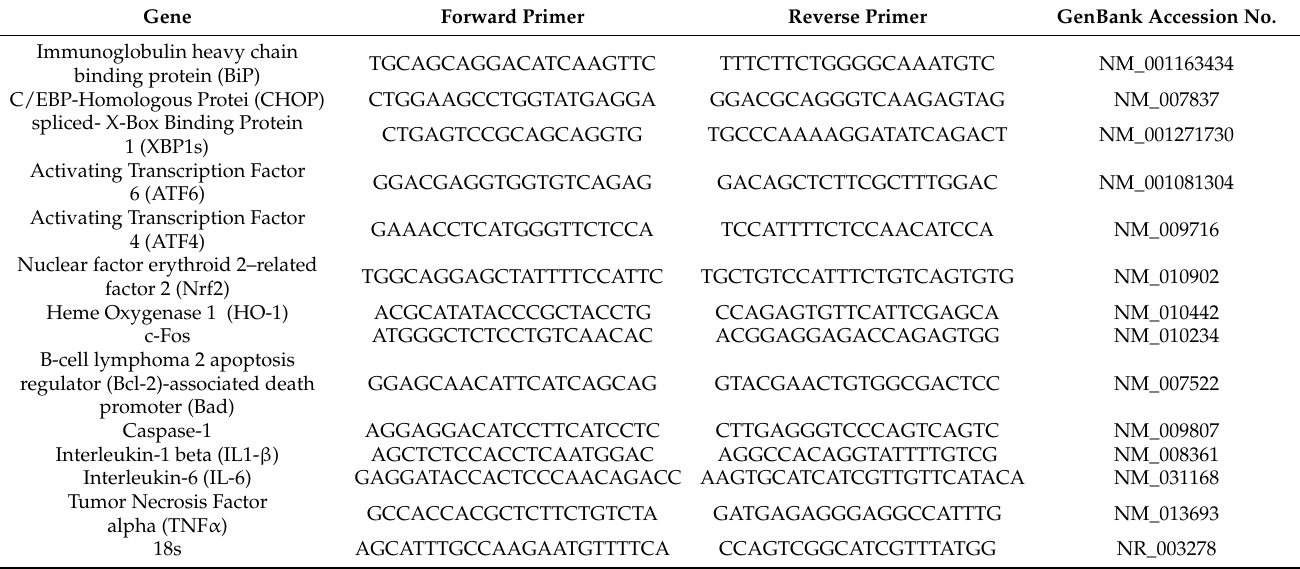
Table 1. Primer list for real time